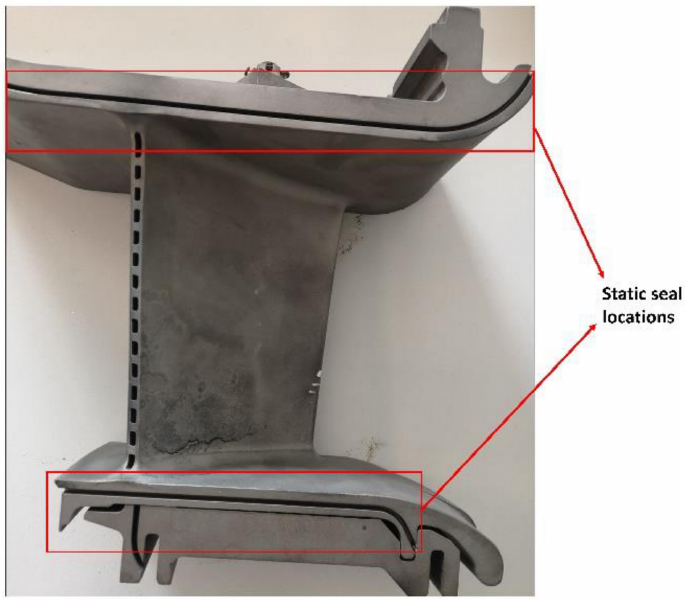
Figure 1. Stationary seal locations in a gas turbine